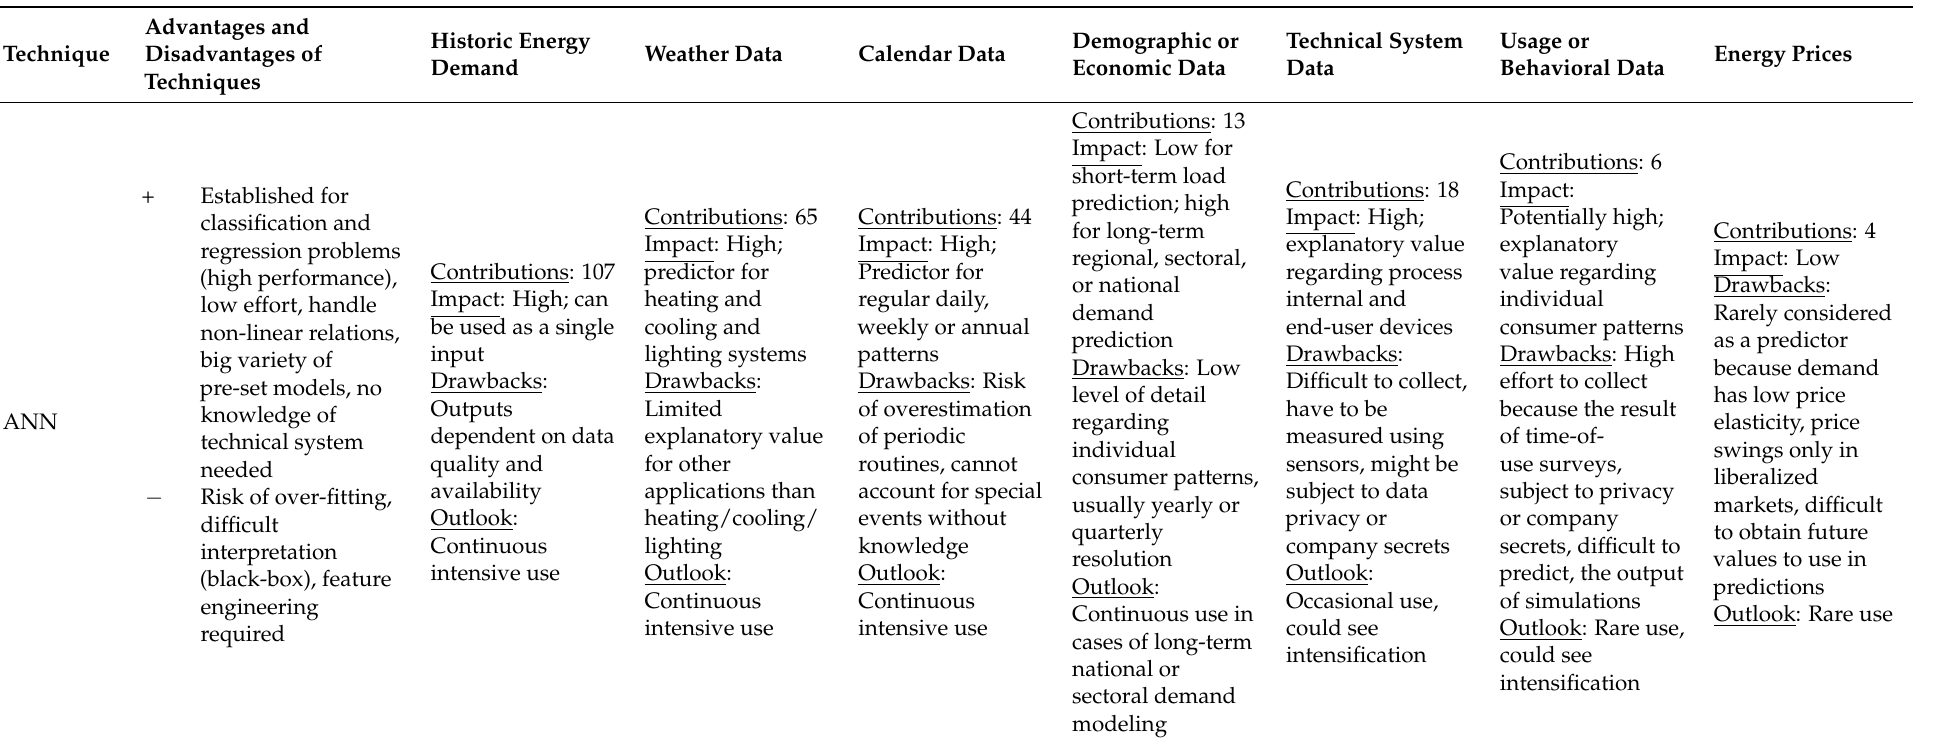
Table 4. Techniques and input data used (1/5). Compiled results of the analysis on techniques and input data. Each cell provides a short assessment of the respective data-technique combination. The corresponding articles for each cell are documented in detail in the structured reference lists in Tables A4–A7 in Appendix